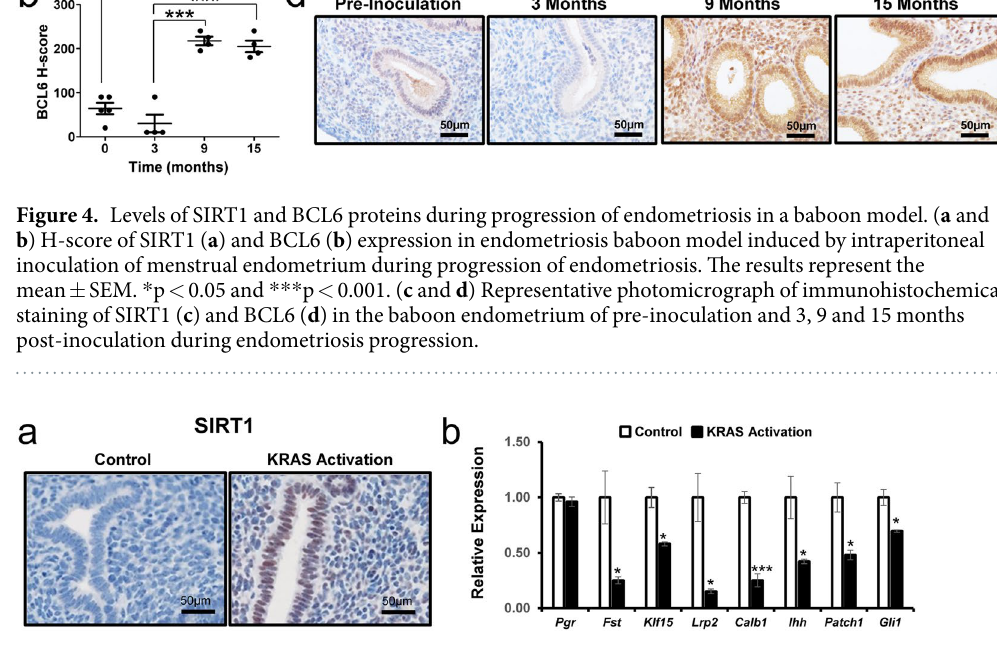
Figure 5. Levels of SIRT1 in the KRAS activation mouse model. ( a ) Representative photomicrograph of immunohistochemical staining of SIRT1 in the control and KRAS activation mouse. ( b ) The mRNA expression level of P4 target genes in the uterus from control and KRAS activation mice (n = 9). The results represent the mean ± SEM. * p < 0.05 and *** p <